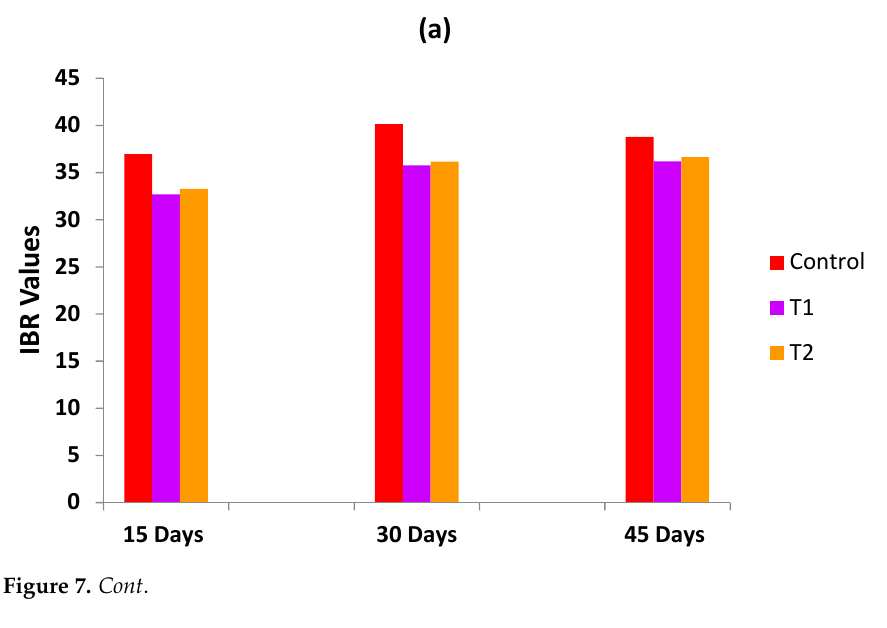
(b) Figure 7. Cont